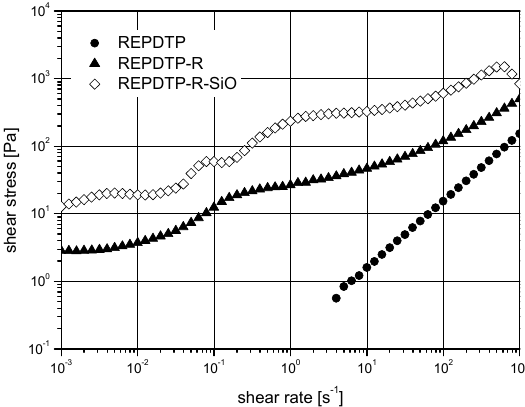
Figure 4 . Shear rate sweeps of REPDTP and its modifications.